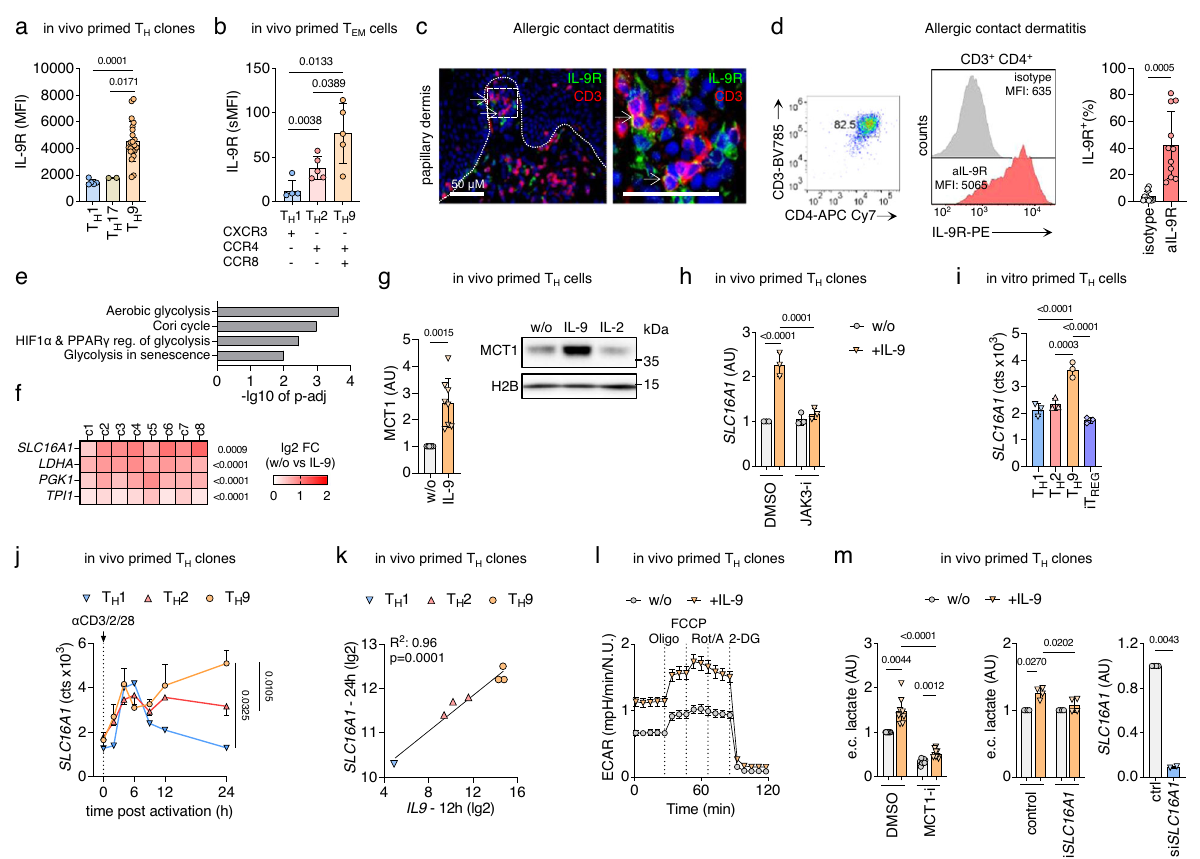
Fig.5|ParacrineIL-9promotesaerobicglycolysisinIL-9R + T H cellsbyinducing the lactate transporter MCT1. a IL-9R levelsof in vivo primed T H clones analyzed by fl ow cytometry. b IL-9R levels of PBMCs stained for their chemokine receptor pro fi lesanalyzedby fl owcytometry. c Immuno fl uorescencestainingforCD3andIL- 9R on ACD skin. Scale bars, 50 μ M. d IL-9R levels of T cells isolated from ACD analyzedby fl owcytometry. e – f RNA-seqofIL-9R + T H cellsisolatedfrombloodand ACDinpresenceofIL-9shows( e )pathwayanalysisofthe250mostsigni fi